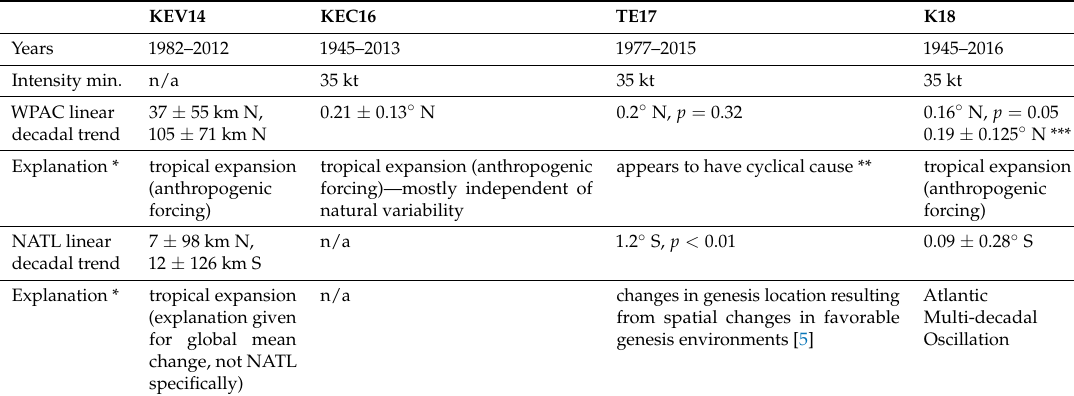
Table 1. A summary of the results from the referenced studies on migration of LMI latitude. Shown are the years of data used for the analysis, the minimum intensity of tropical cyclones included, the linear trend for the North Atlantic (NATL) and western North Pacific (WPAC) Oceans (given in linear rate of change per decade), and the explanation given for those trends, if any, as presented in the publications. The 95% confidence bounds or p-values are included when given. KEV14 used two data sets and both trends are listed. The linear trend in the WPAC listed in KEC16 and the second WPAC trend listed in K18 is the trend of the residuals after accounting for the Pacific Decadal Oscillation and El Niño Southern Oscillation. The second NATL trend listed for K18 is the residual trend after accounting for the Atlantic Multidecadal